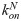
Reversible segregation of microtubules and neurofilaments in a single realization of the model.Neurofilament transport is blocked starting at t = 1 h and restored at t = 13 h. (A-F) Snapshots of the positions of microtubules, neurofilaments and organelles at t = 1 h, 3 h, 6 h, 12 h, 14 h, 20 h. All panels are from a single realization of the model. Large black dots are microtubules; small grey dots are free neurofilaments; small purple dots are neurofilaments engaged with microtubules; large cyan circles are organelles. (A) Microtubules and neurofilaments form a mixture under normal conditions. (B-D) Blockage of neurofilament transport leads to gradual segregation of microtubules and neurofilaments. (E,F) Restoration of neurofilament transport causes remixing of microtubules and neurofilaments. Parameters used: n
M = 56, n
N = 361. Neurofilament on-rate konN equals 0 between t = 1 h and 13 h. All other parameters are the same as in Table 1.